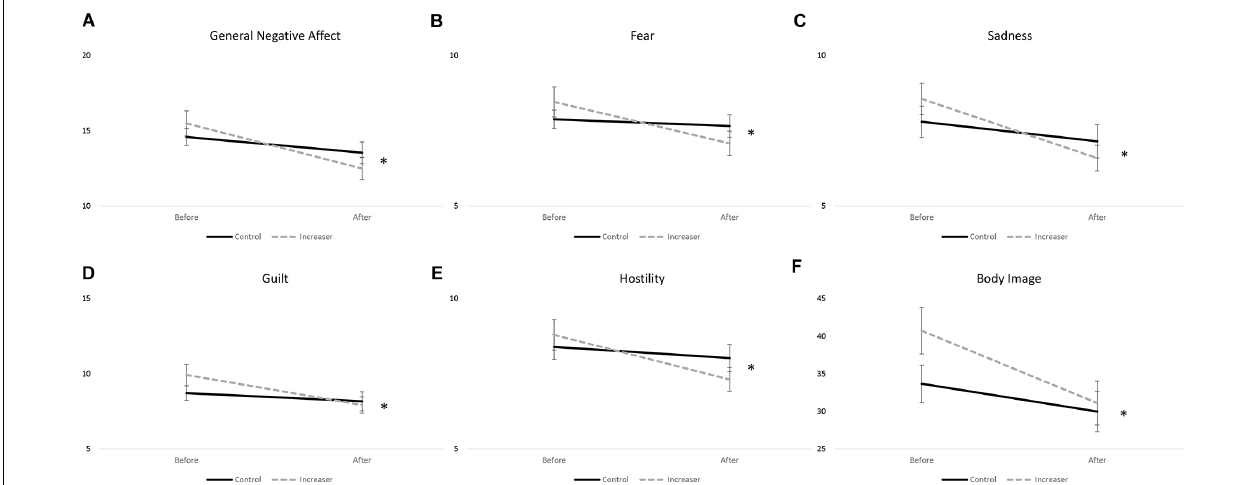
FIGURE 3 | Significant time by group effects for (A) general negative affect; (B) fear; (C) sadness; (D) guilt; (E) hostility; and (F) body image. Data presented as mean ± SEM. ∗ p < 0.05.